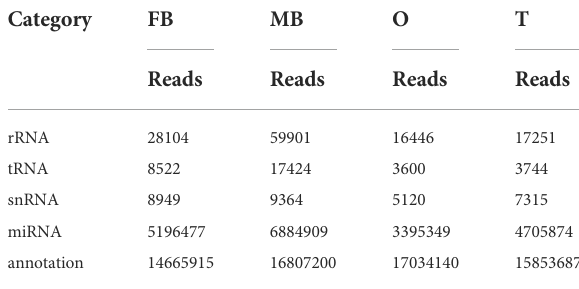
TABLE 2 Statistics of known and novel miRNAs in four small RNA libraries. Note:FB,female brain;MB,malebrain; O,ovary;T,testis. Library Known